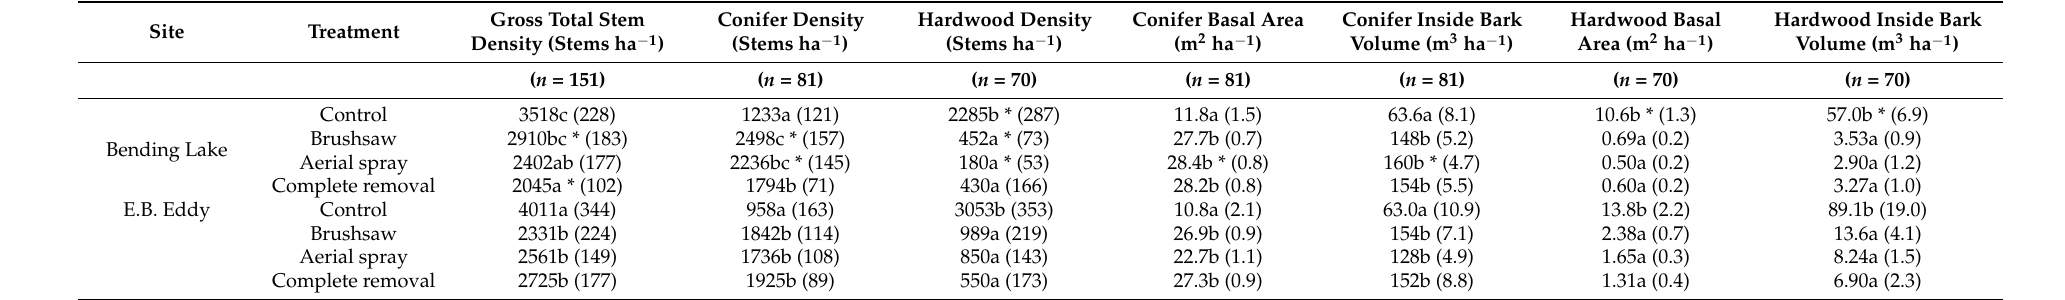
Table 3. Estimated marginal means ( ± SE) for stand growth and yield indicators grouped by site x treatment combinations after vegetation management treatments applied on two sites (Bending Lake and E.B. Eddy) in Ontario, Canada. Different lowercase letters indicate statistically significant differences from Tukey’s honest significant difference (HSD) test (pairwise comparisons between each treatment and control) within each site. Asterisk (*) indicates statistically significant differences from pairwise comparisons between